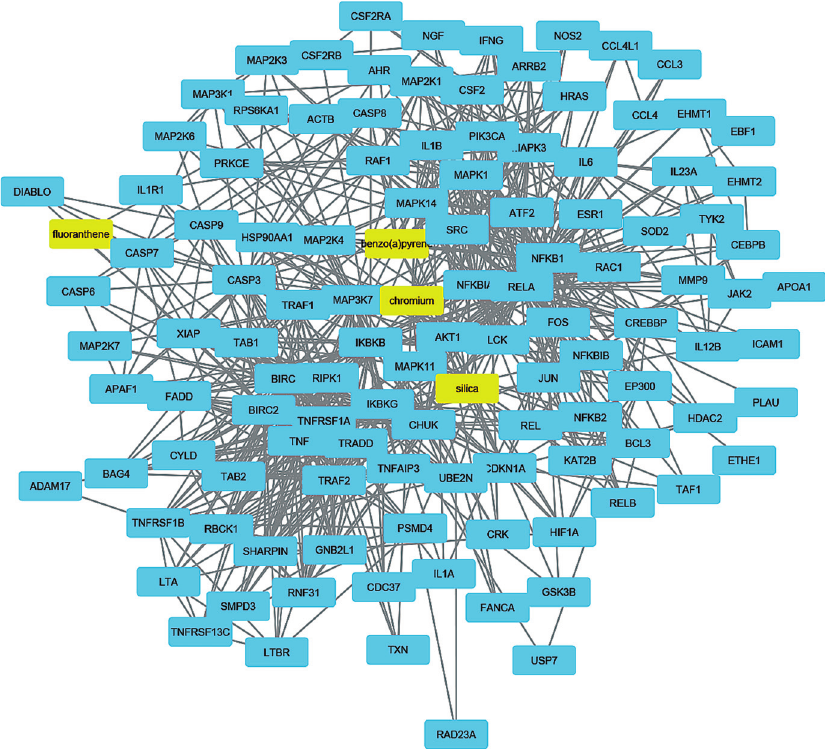
Figure4 -ClusteranalysisofthemajorCPI-PPInetworkshowingtheassociationofcluster13withMIOs,IEs,andPAHs(yellow).Itiscomposedof118 nodes and 732 edges, with Ci = 12,303. The associated constituents include SiO 2 , Cr, fluoranthene, and